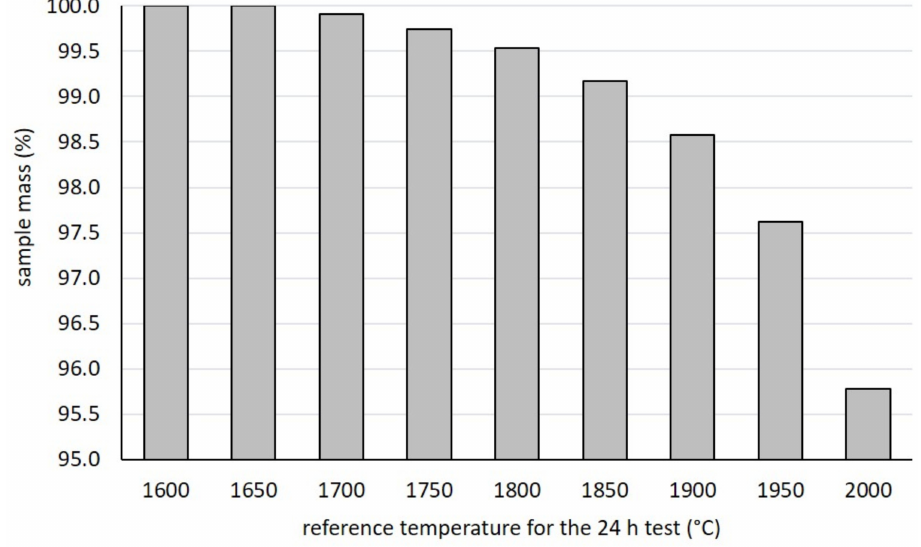
Figure 13. Sample mass (%) monitored at the end of every specific test (24 h at constant